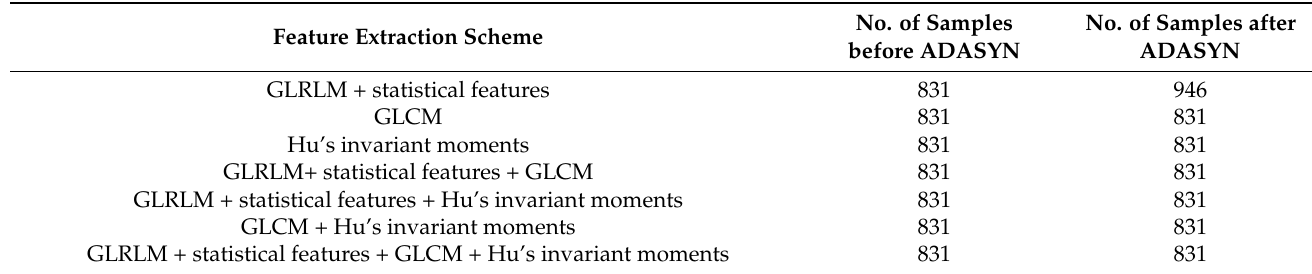
Table 1. Amount of samples before and after applying